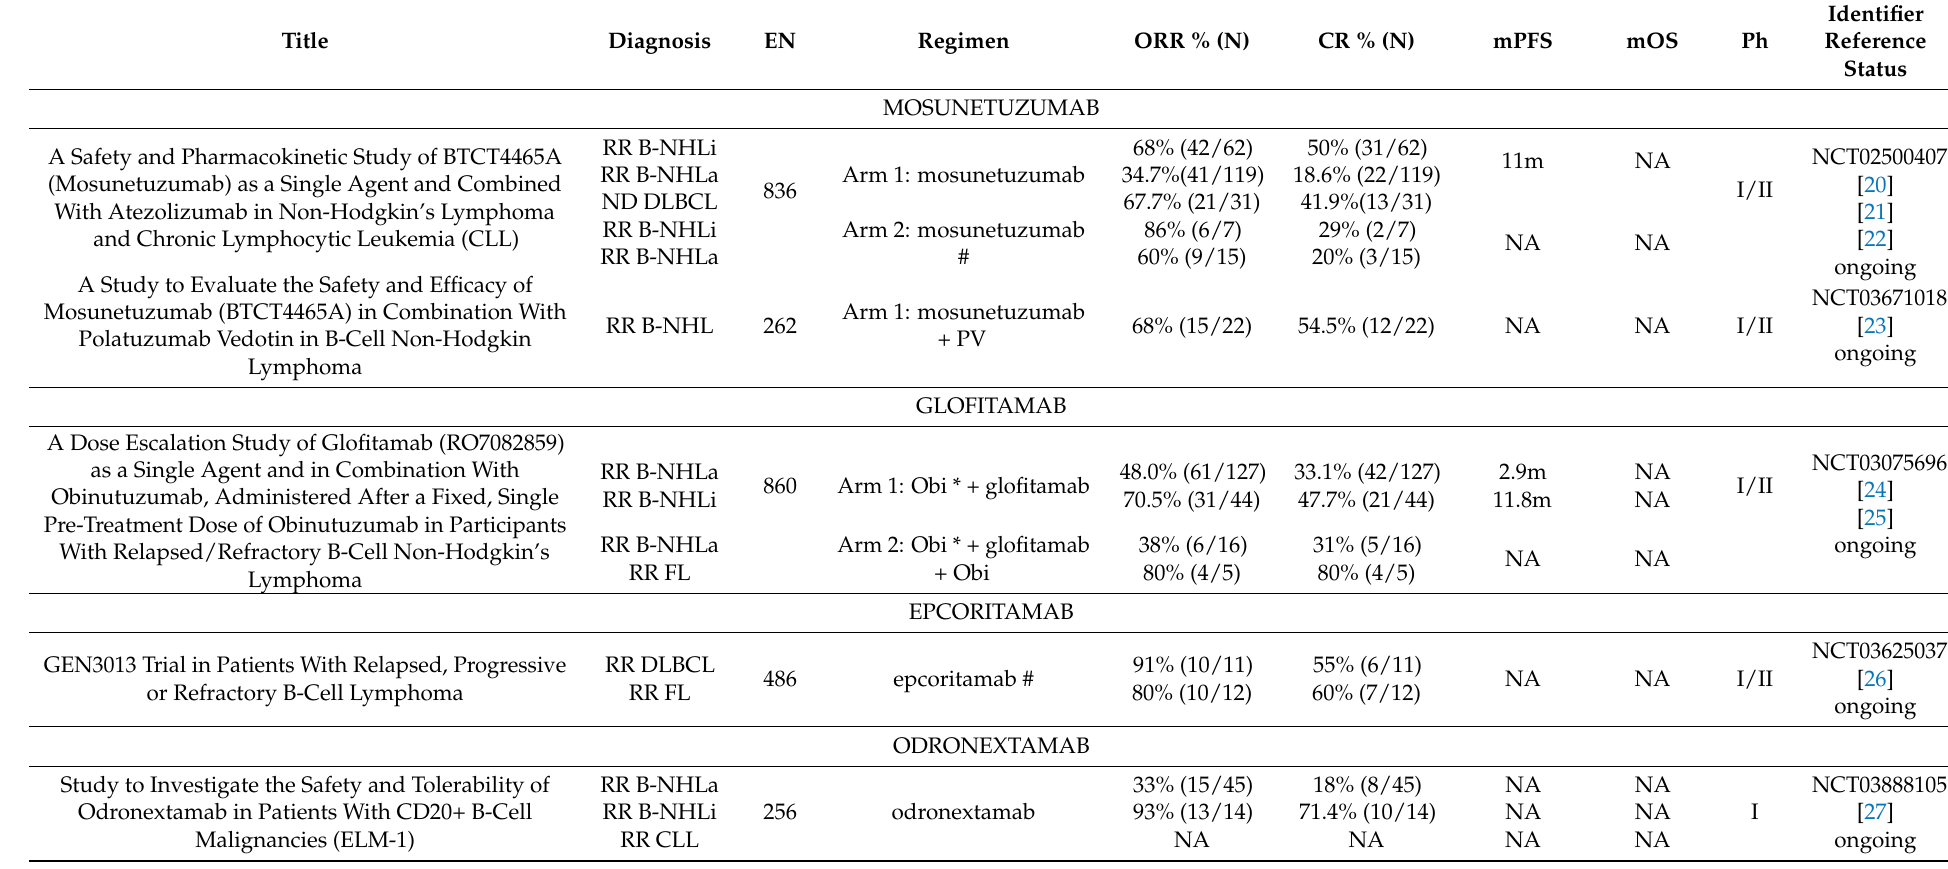
Table 4. Anti-CD20xCD3 TCEs-available results of phase I-II clinical trials; EN, estimated enrollment; ORR, overall response rate; CR, complete remission; PR, partial remission; mPF, median progression free survival; mOS, median overall survival; m, month; RR, relapse and/or refractory; B-NHL, B-cell non-Hodgkin lymphoma; i, indolent; a, aggressive; N, number; NA, not available; Obi, obinutuzumab; Ph, phase; * obinutuzumab pretreatment; # subcutaneous